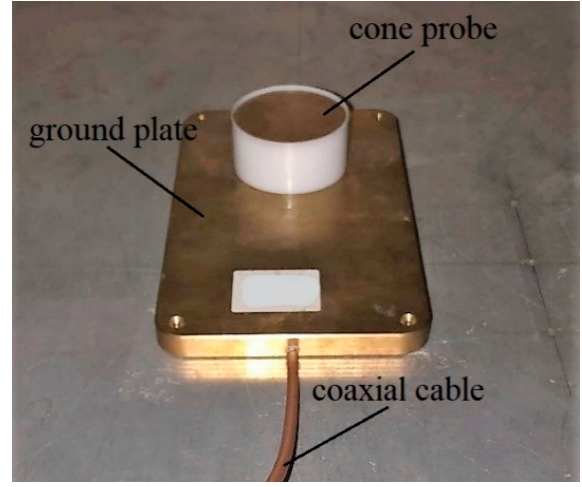
Figure 4. Physical diagram of D-dot sensor. Where the half cone angle of the probe is 47°.